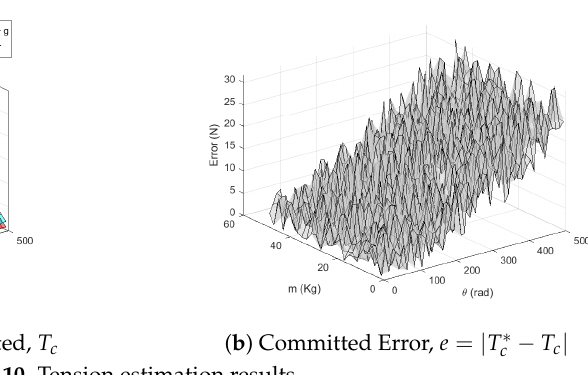
Figure 10. Tension estimation results.